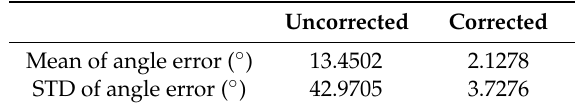
Figure 13. Heading angle results for two paths: ( a ) angle in large interference; and ( b ) angle in small interference. Table 2. Test Occasion 2: Mean and STD of the heading angle error under large interference.